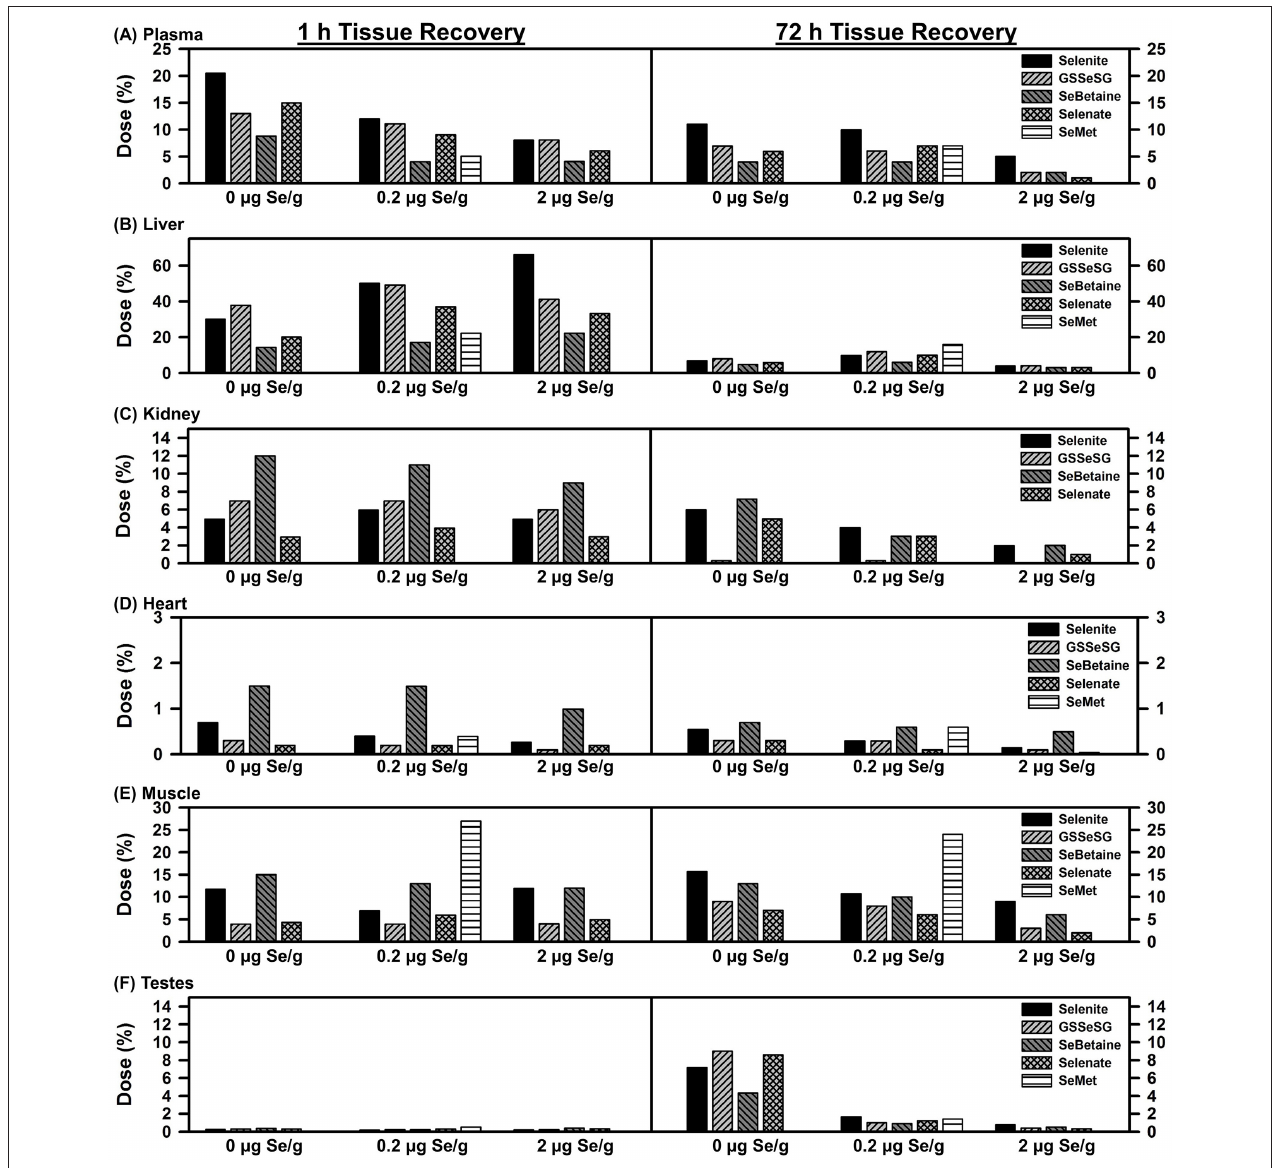
FIGURE 2 | Tissue 75 Se recovery at 1 and 72h after injection 75 Se selenocompounds. Rats were treated as described for Figure 1 . Values are the percent of the administered 75 Se dose recovered in each tissue ( n = 1 per treatment at each time for each selenocompound, n = 26